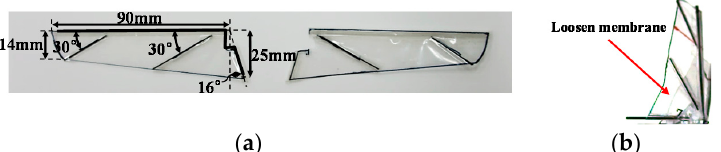
Figure 3. ( a ) Passive wing rotation mechanism using a loose wing membrane and ( b ) loosen membrane in moving wing.